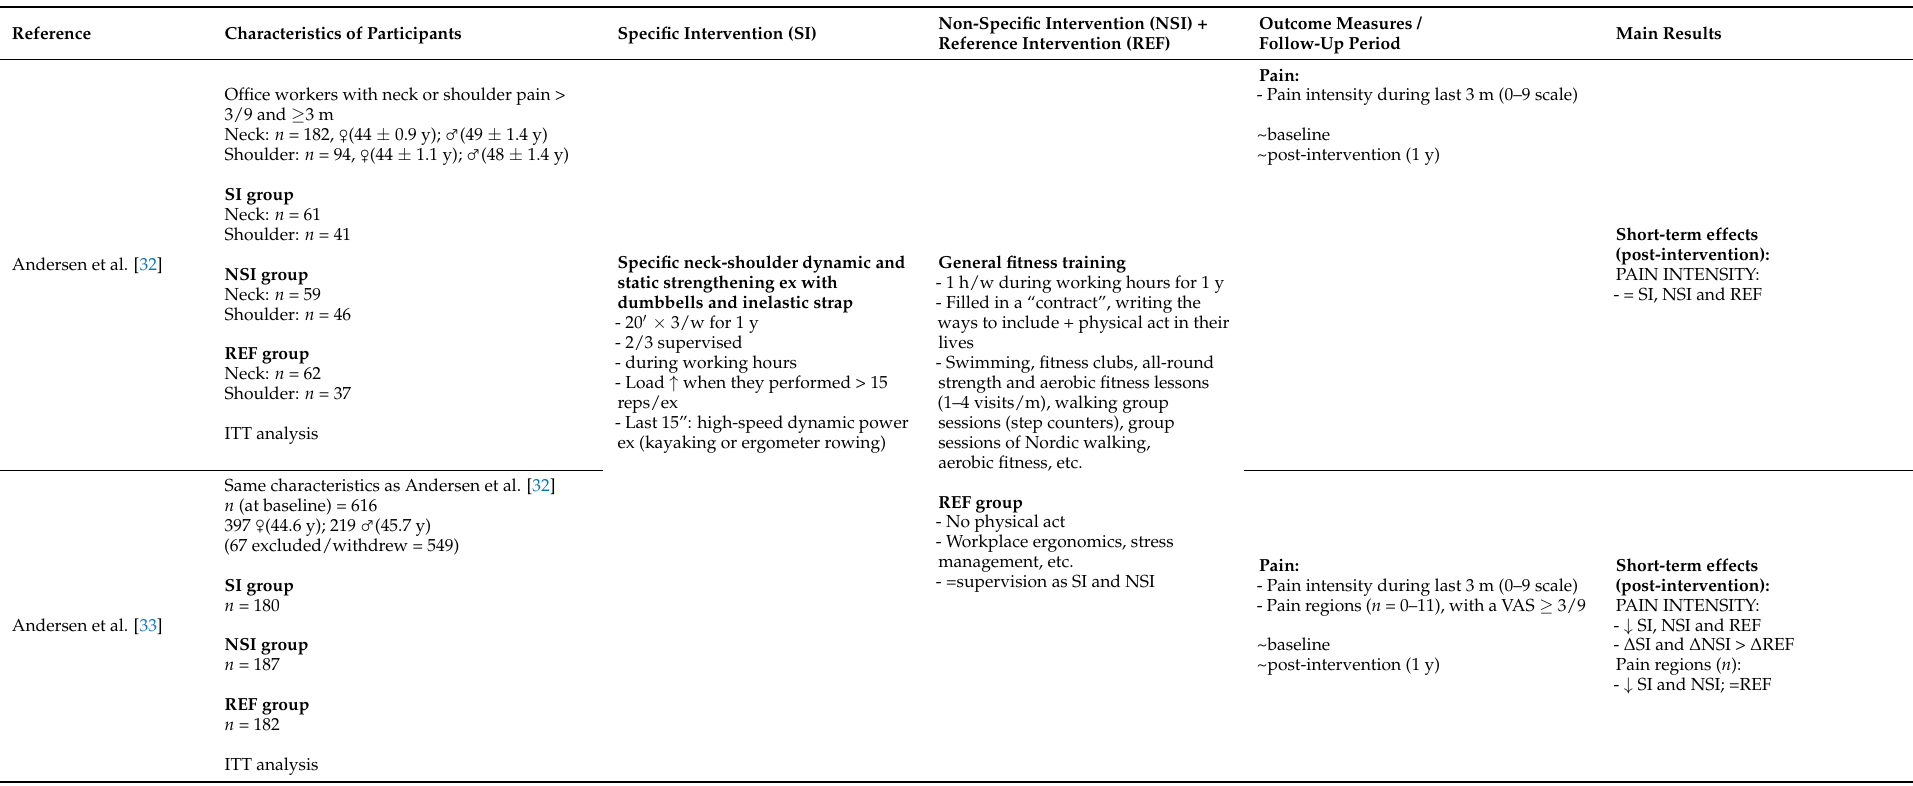
Table 3. Study characteristics. Specific strength vs. non-specific aerobic